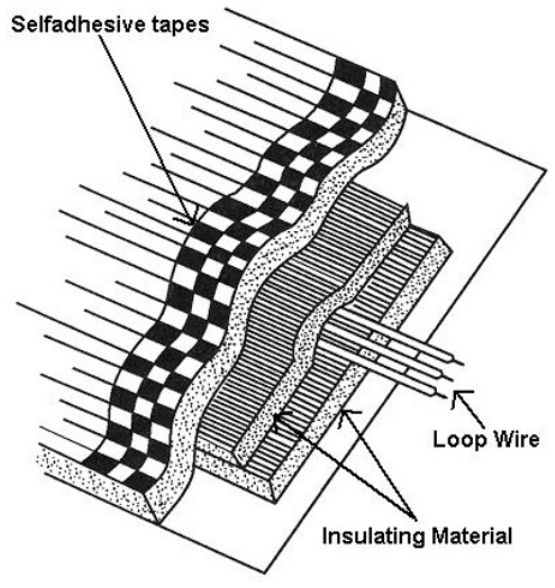
Figure 9. Temporary inductive loop